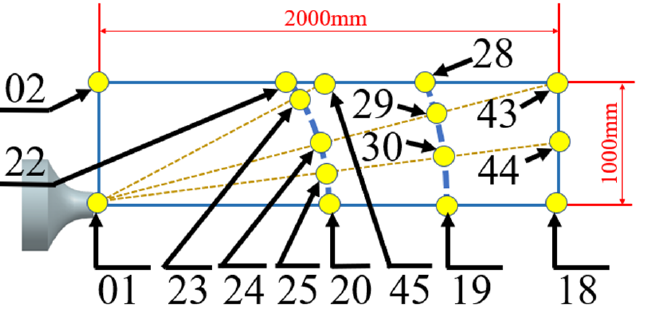
Figure 3. Schematic diagram for the arrangement of remote field monitoring points of the equal- diameter nozzle and standard nozzle.